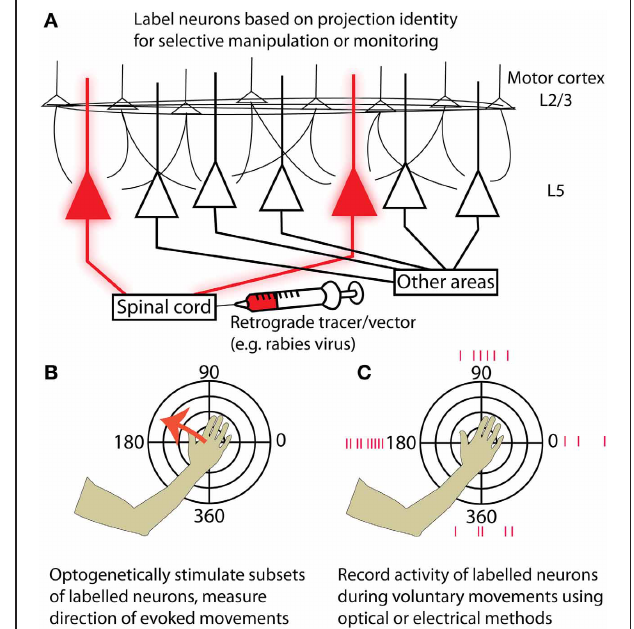
FIGURE 1 | Strategies for targeting neurons in motor cortex based on their projection identity. (A) Injecting a retrograde tracer or viral vector into a region downstream of motor cortex (for example, the spinal cord) will label neurons in motor cortex that project to that area. (B) By expressing optogenetic activators such as Channelrhodopsin-2, neurons of the targeted projection class can be selectively activated while resulting movements are measured. Motor maps generated by stimulating specific projection classes can be tested for topographies of evoked movement direction and compared with maps from other projection classes. (C) Alternatively, the activity of labeled neurons can be measured while an experimental animal makes voluntary movements in different directions. This could be accomplished either with electrical recordings or by imaging genetically encoded calcium or voltage indicators. Again, preferred movement directions can be examined at different cortical locations for neurons in a given projection class, and different projection classes can be compared by performing retrograde injections in multiple structures targeted by cortical output